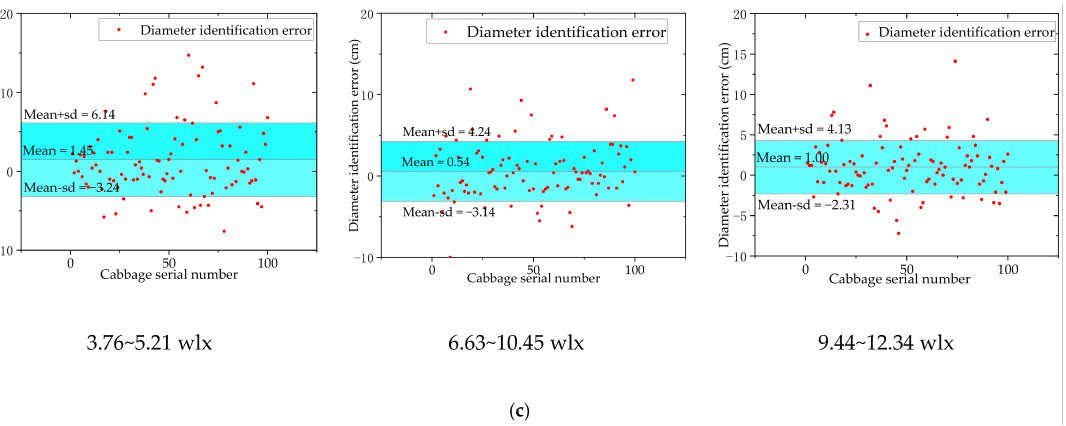
Figure 15. Identification results under different lighting conditions. ( a ) Advance opening distance. ( b ) Delay closing distance. ( c ) Diameter identification error.